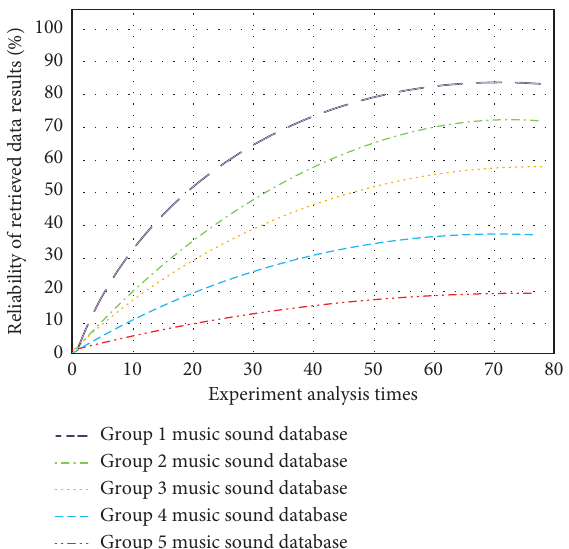
Figure 8: Reliability of the corresponding retrieved data results under different experimental analysis times under the collaborative filtering algorithm.